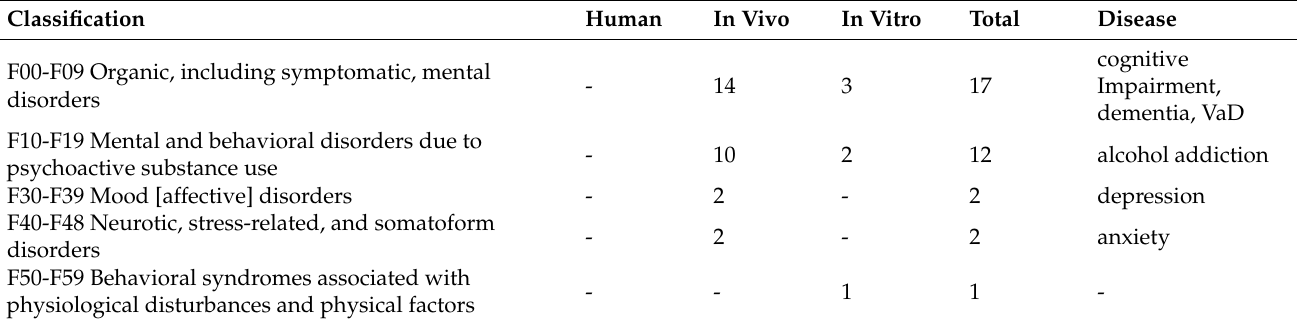
Table 11. The statistics of pharmacological results and its major diseases of SMC by experimental type in V Mental and behavioral disorders of